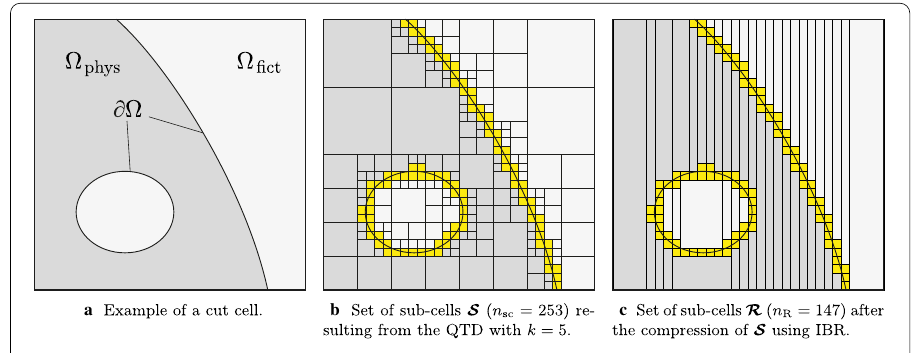
Fig. 9 Exemplary cut cell ( a ) and the resulting sets of integration sub-cells when a QTD ( b ) or the IBR algorithm ( c ) are applied. Note that the local coordinate systems ξ are not depicted in the sub-figures for